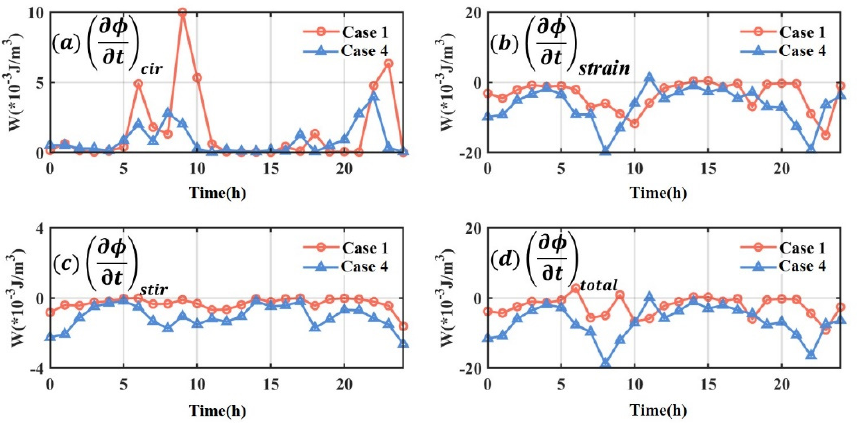
Figure 13. Time series of the derivatives of the potential energy due to ( a ) gravitational circulation (( ∂ϕ / ∂ t)cir), ( b ) tidal straining (( ∂ϕ / ∂ t)strain), ( c ) tidal stirring (( ∂ϕ / ∂ t)stir), and ( d ) total time derivative of the potential energy anomaly (( ∂ϕ / ∂ t)total) using Equation (9) on 2 July at station S1 shown in Figure 1b.